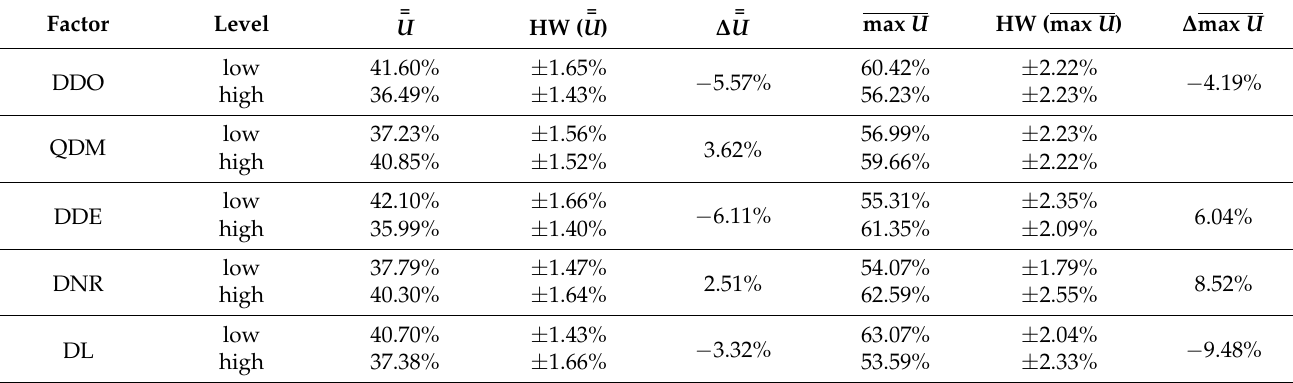
Table 6. Sensitivity analysis of the scenario